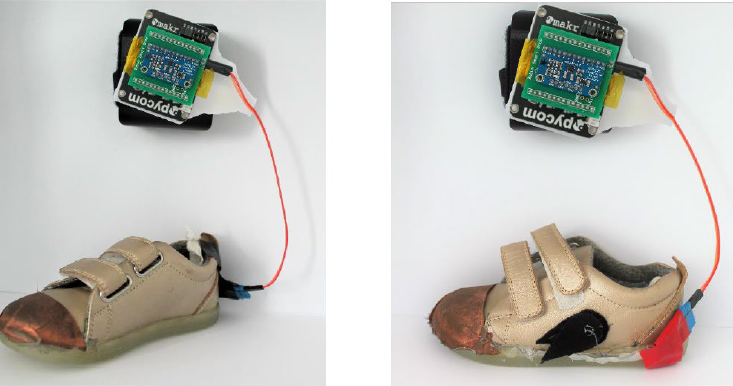
Figure 19. ( Left ) Non-grounded heel sensor connected to Pycom and MPR121, ( Right ) Grounded heel sensor connected to Pycom.